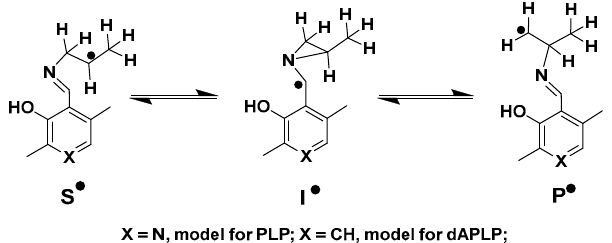
Scheme 3. Model of radical intermediates in the reaction of 5,6-LAM with